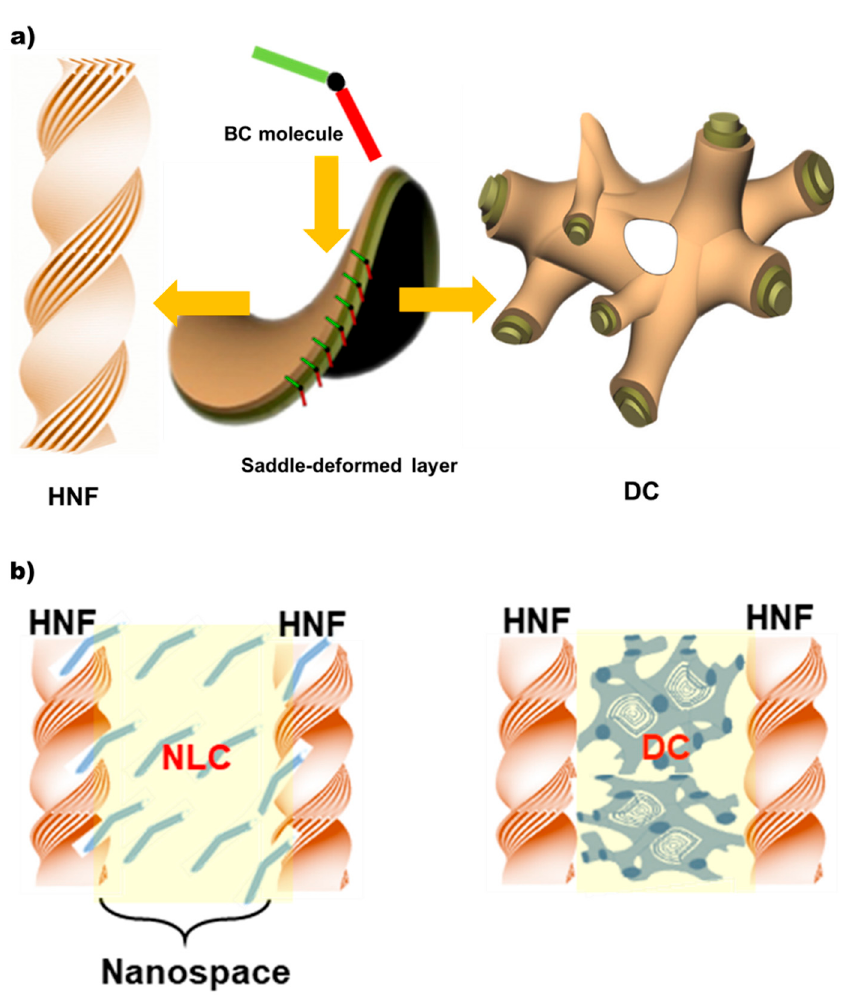
Figure 1. ( a ) Schematic representations of HNF and DC structures. The upper and lower halves of the BC molecule organize orthogonally, forming a saddle-deformed layer structure. The saddles assemble either the HNF or DC structures. ( b ) Two nanosegregated phases exhibit different hierarchical molecularly organized BC guest molecules embedded in the nanospaces generated between BC-host molecular HNFs. Illustrations on the left and right indicate <HNF/N> and <HNF/DC>, respectively. <HNF/N (or DC)> refers to a nanosegregated phase in which BC-1 and BC-2 are in the HNF and NLC (or DC) phases, respectively.